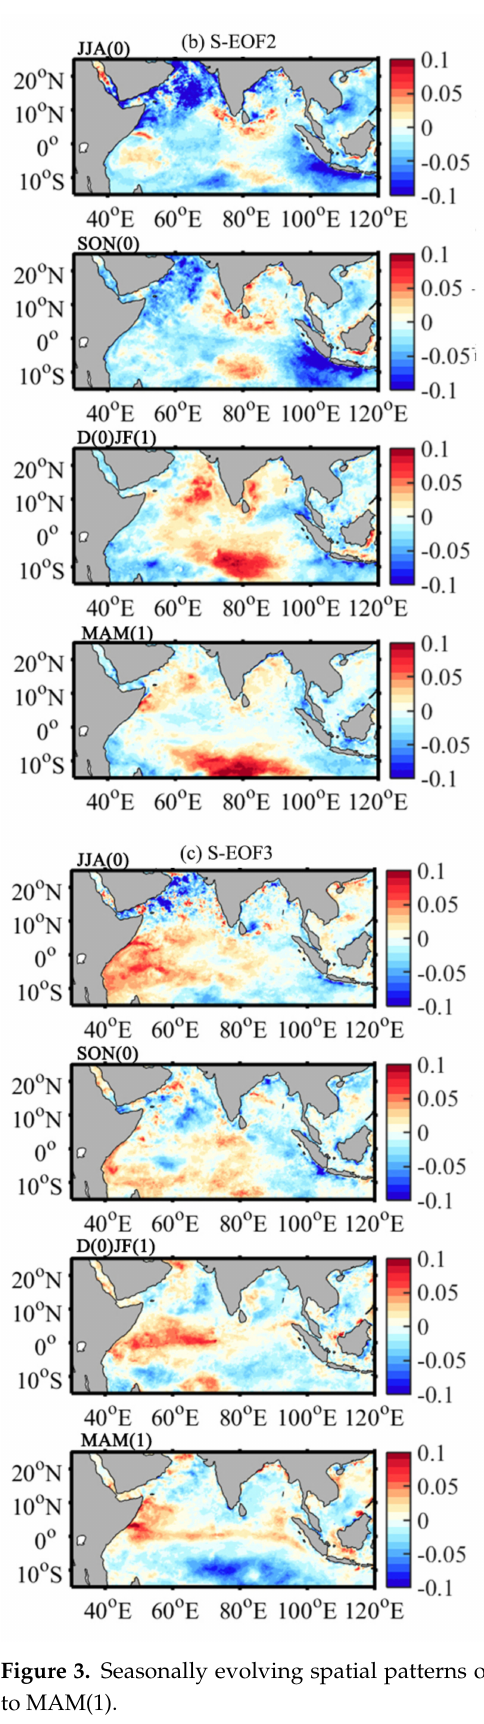
Figure 3. Seasonally evolving spatial patterns of the first three S-EOF modes of Chla from JJA(0) to